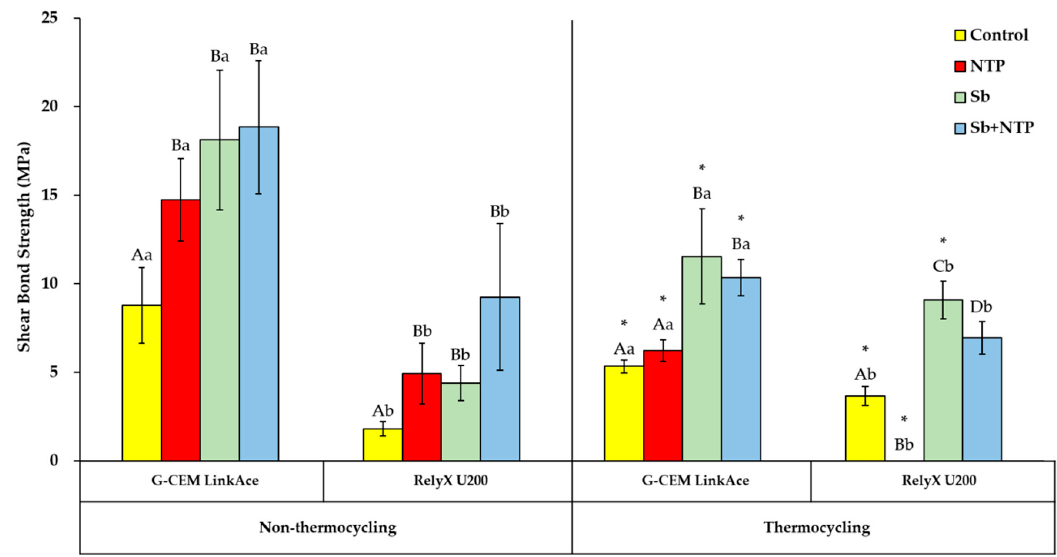
Figure 7. Mean SBS results of the Control, NTP, Sb, and Sb + NTP groups in accordance with the thermal effect and the type of self-adhesive resin cement. The different upper case letters indicate significant differences between surface treatments within the same thermal effect and the cement type ( p < 0.05). The different lower case letters indicate significant differences between cement types within the same surface treatment in each thermal effect ( p < 0.05). * indicates significant differences between thermal effects within the same surface treatment in each cement ( p < 0.05).